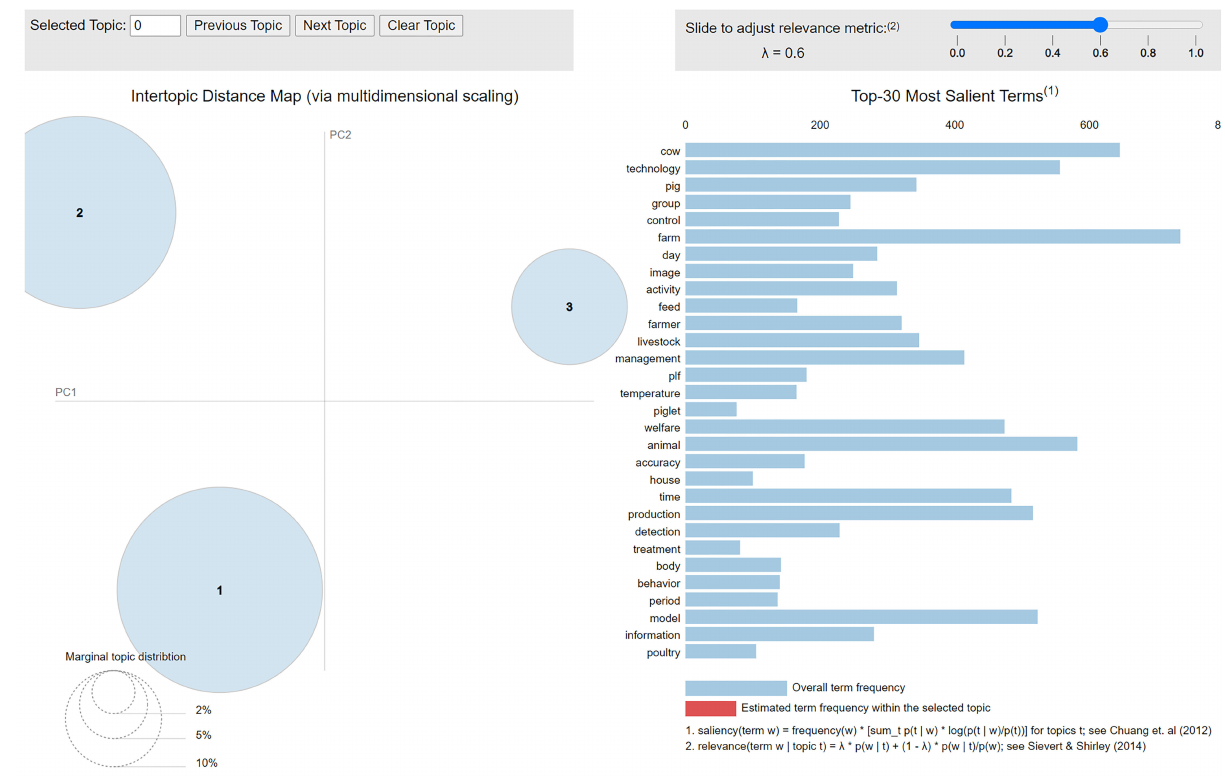
FIGURE 5 | Overview of the results produced by LDA Model 2 (250 passes, 3 topics) with the relevance metric ( λ ) set to 0.6 and no specific topic cluster selected. Topics 1 and 2 depict broader generalistic PLF clusters with a predominant focus on dairy cattle. Topic 3 is more specifically oriented toward pig and poultry production and aspects such as feeding, housing, and